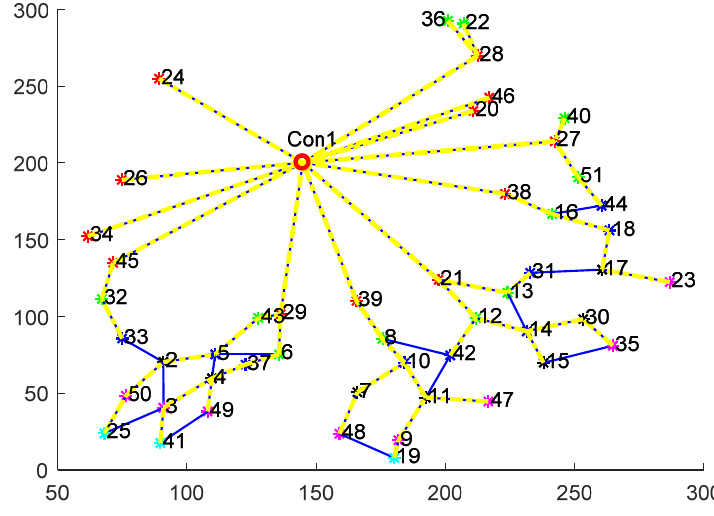
Figure 16. Logical topology after dynamic selection of relay.